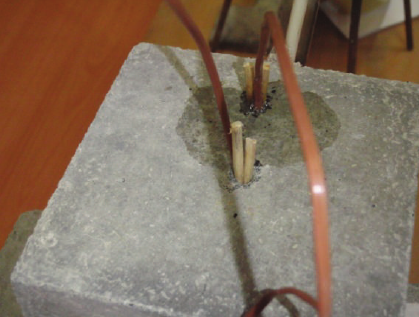
Figure 10: Detail of escaping moisture at the 𝑇 2 location, specimen CEM I -